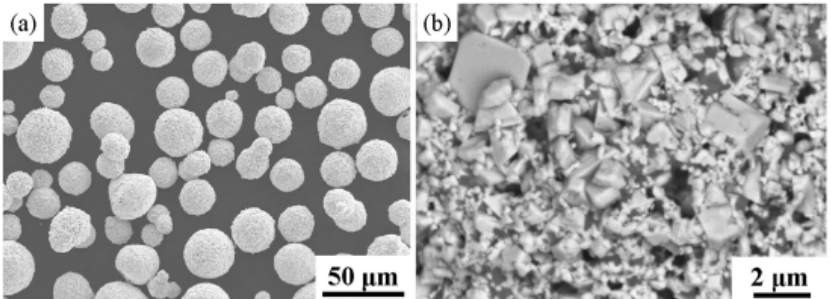
Figure 8. Form of WC-(nano WC/Co) raw material powder: ( a ) raw material powder; ( b ) WC particles [58]. Reprinted with permission from [58]; 2018 Elsevier.